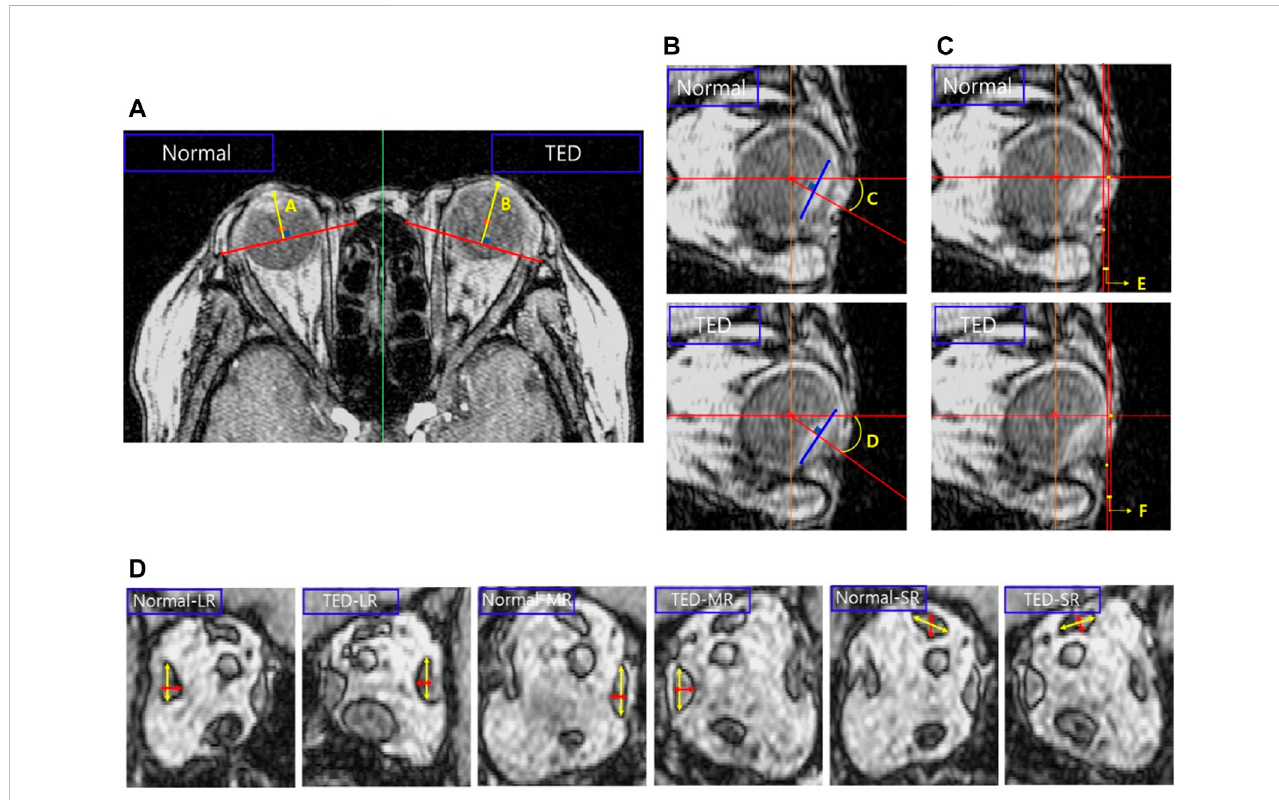
FIGURE 1 Analysis of major dimensions in the thyroid eye disease (TED) orbit and normal orbit based on magnetic resonance imaging (MRI). (A) Proptosis measurement. (B) Eye rotation measurement. (C) Distance measurement between the ocular and skin end point. (D) Thickness and width measurements in the extraocular muscle (EOM) except for the inferior rectus (IR) muscle.